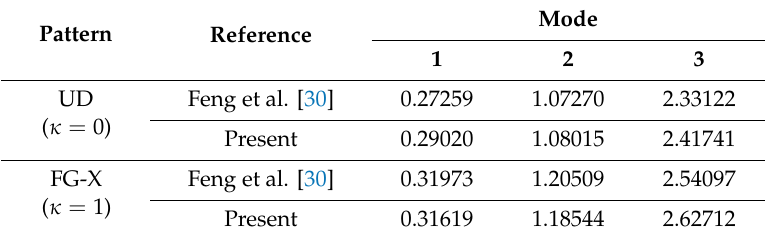
Table 2. First three dimensionless nonlinear frequencies ( ω NL = ω NL × L × supported laminated beams reinforced with GPLs ( L / h t = 20).